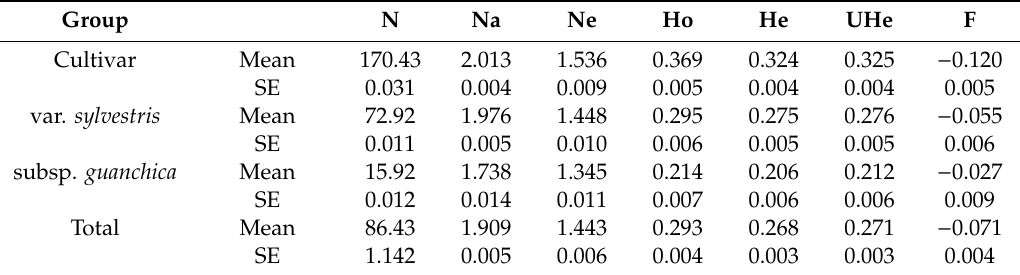
Table 2. Heterozygosity, F-statistics, and polymorphism by population. Group N Na Ne Ho He UHe F Cultivar